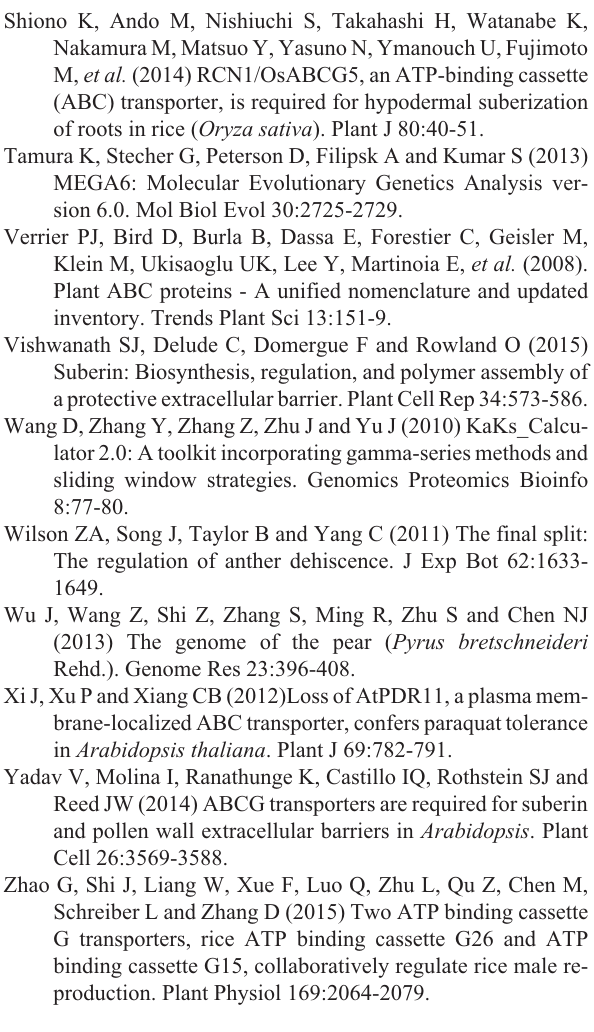
Figure S1 - Visualization of the PbABCG genes mapped onto the different chromosomes in the pear genome. Figure S2 - Localization and duplication of the PbABCG genes in the pear genome. Figure S3 - The conserved motifs in the proteins. Figure S4 - Exon structure. Table S1 - Characteristics of PbABCG genes in pear. Table S2 - Primer sequences. Table S3 - Synteny and Ka/Ks related to genes in PbABCG genes in